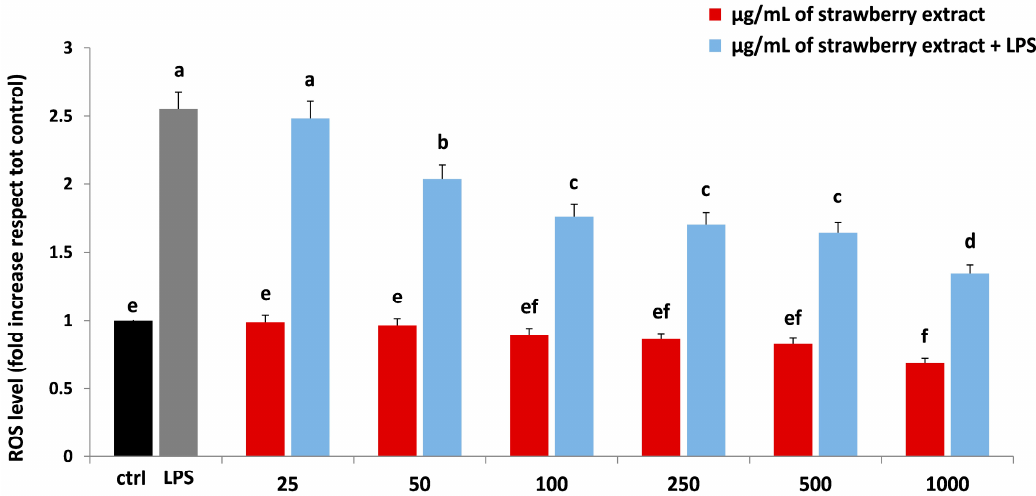
Figure 4. ROS level in HDF cells treated with different concentrations of strawberry extracts (25–1000 µg/mL) for 24 h (red bars), LPS (10 µg/mL) for 24 h (grey bar) and with different concentrations of strawberry extracts and then with LPS (blue bars). Black bar represents the control group. Data are expressed as mean values ± SD. Columns with different superscript letters are significantly different ( p < 0.05).